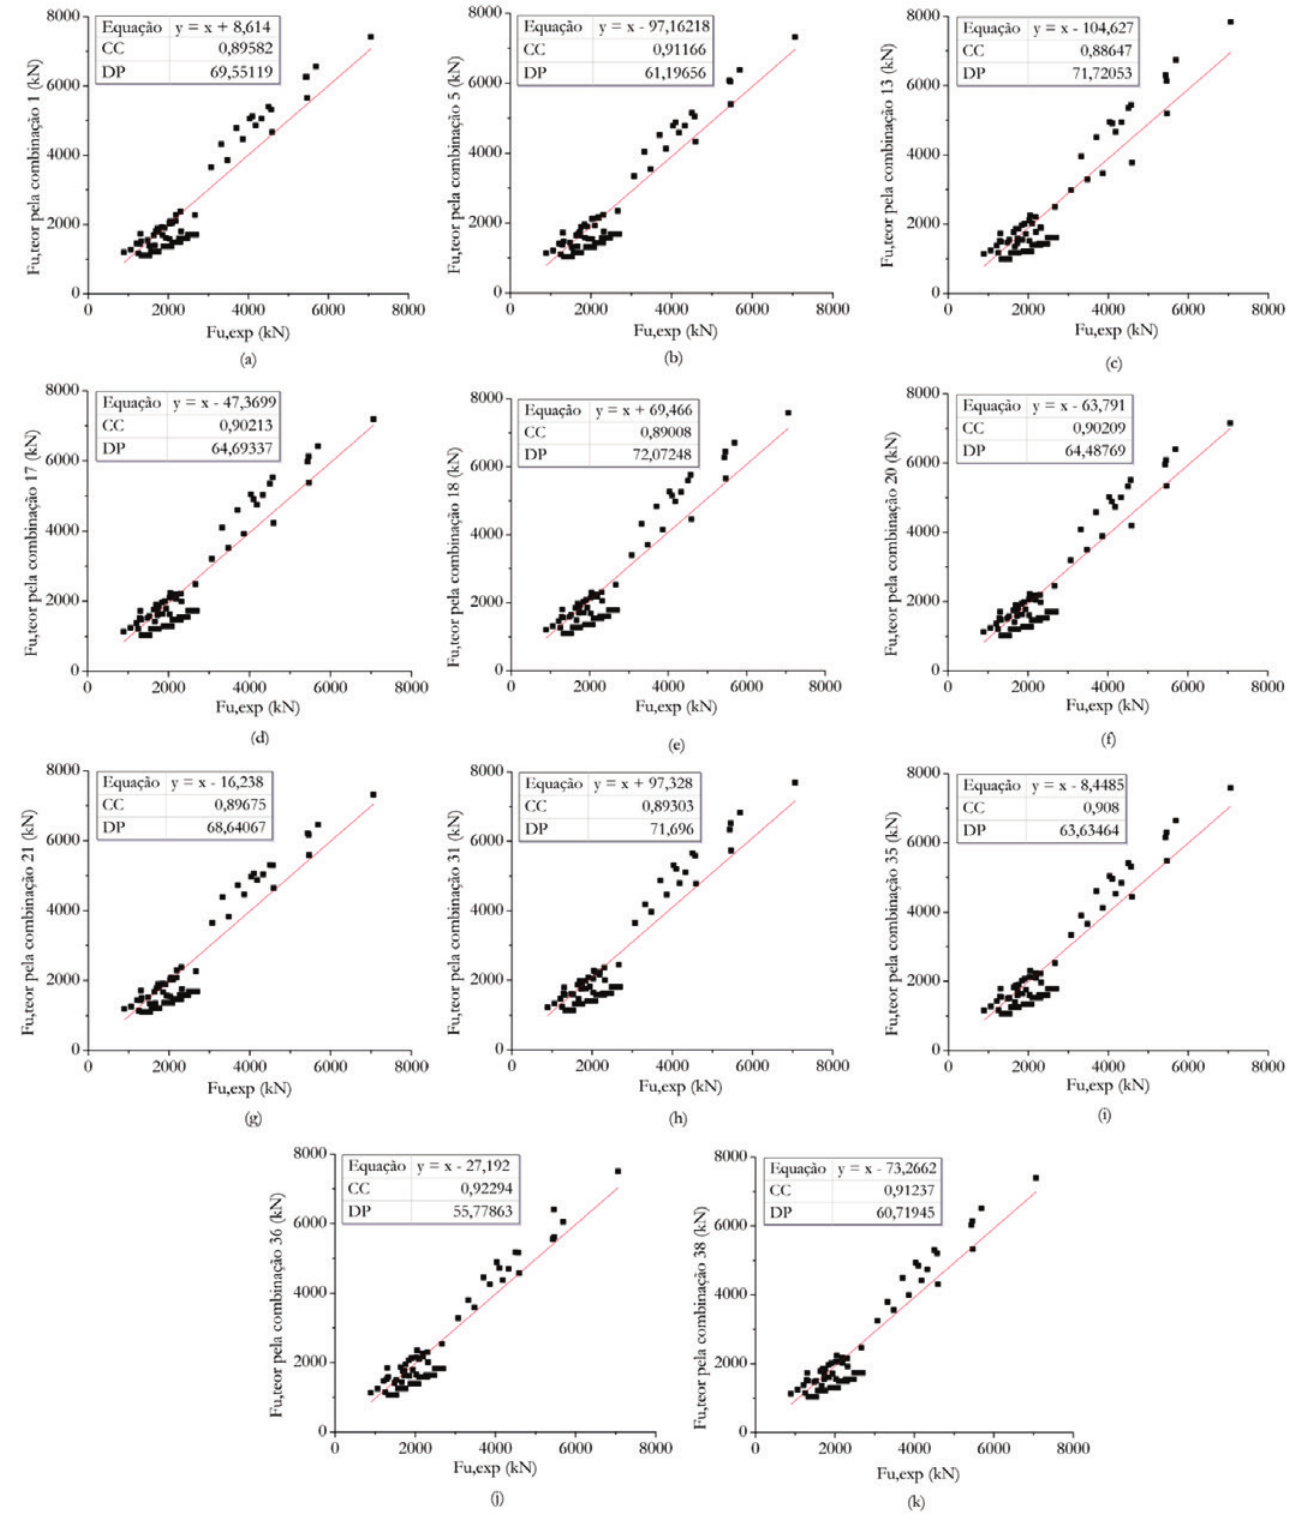
Figura 11 Comparação teórico-experimental da capacidade resistente (F armadura transversal. (a) Combinação 1; (b) Combinação 5; (c) Combinação 13; (d) Combinação 17; (e) Combinação 18; (f) Combinação 20; (g) Combinação 21; (h) Combinação 31; (i) Combinação 35; (j) Combinação 36; (k) Combinação 38. CC: Coeficiente de correlação; DP: Desvio